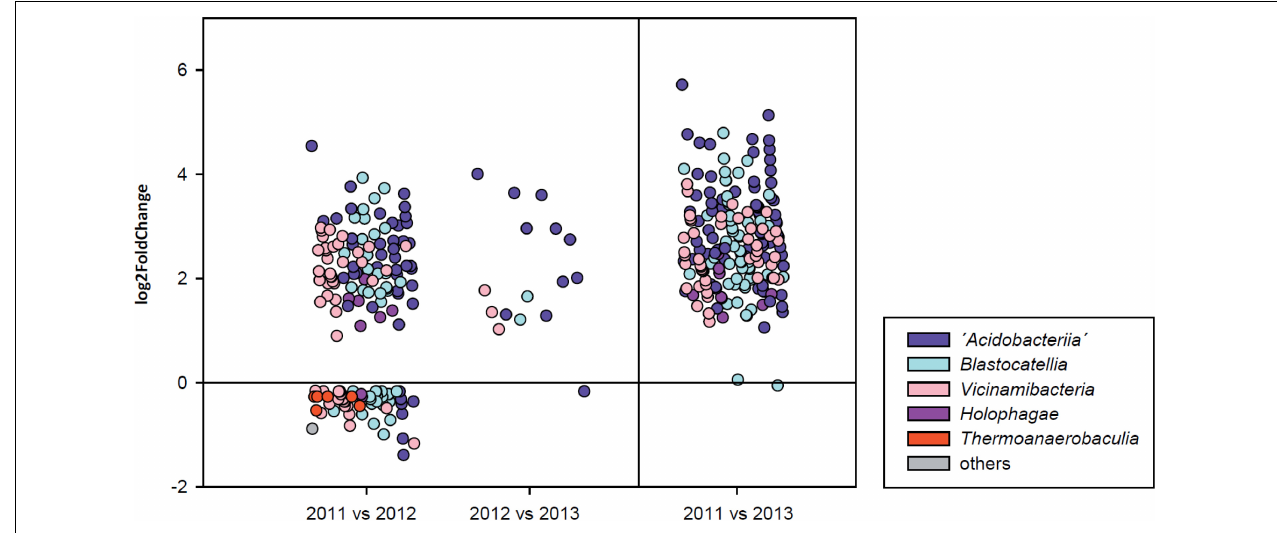
FIGURE 5 | Differential abundance analysis (following ANCOM BC tests) of individual sequence variants after rainy seasons over consecutive 1-year observation periods (left panel) and the entire 2-year period (right panel) . Different colors reflect the taxonomic affiliation at class